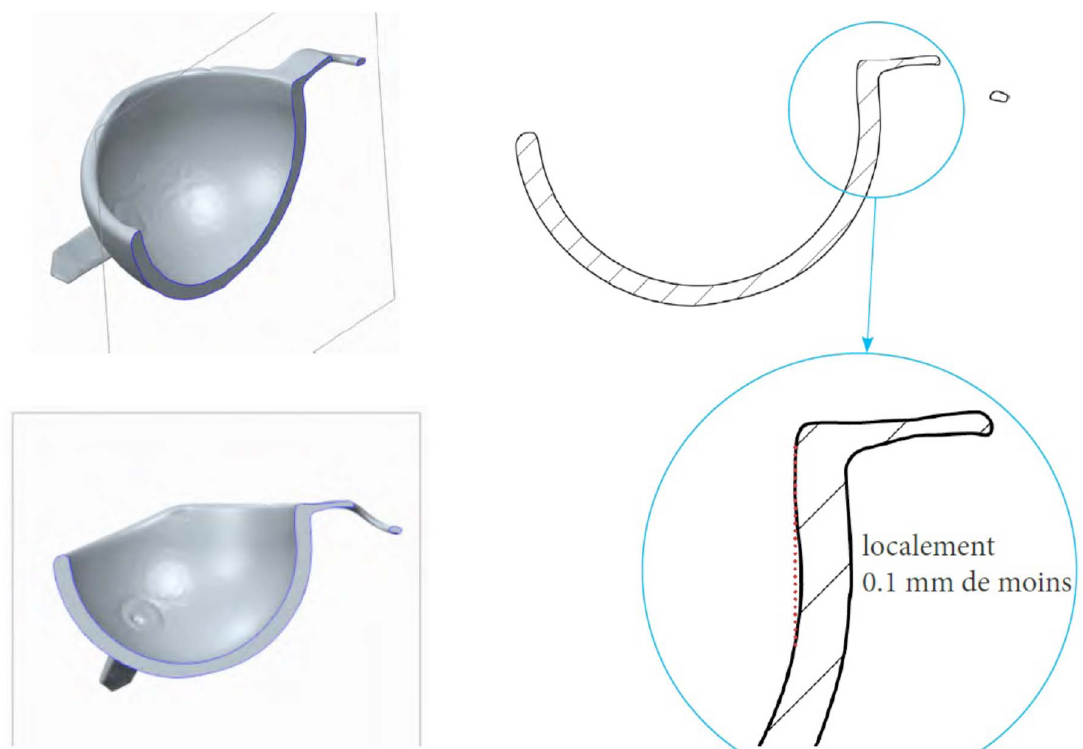
Figure 6. Wear of the metal-backed